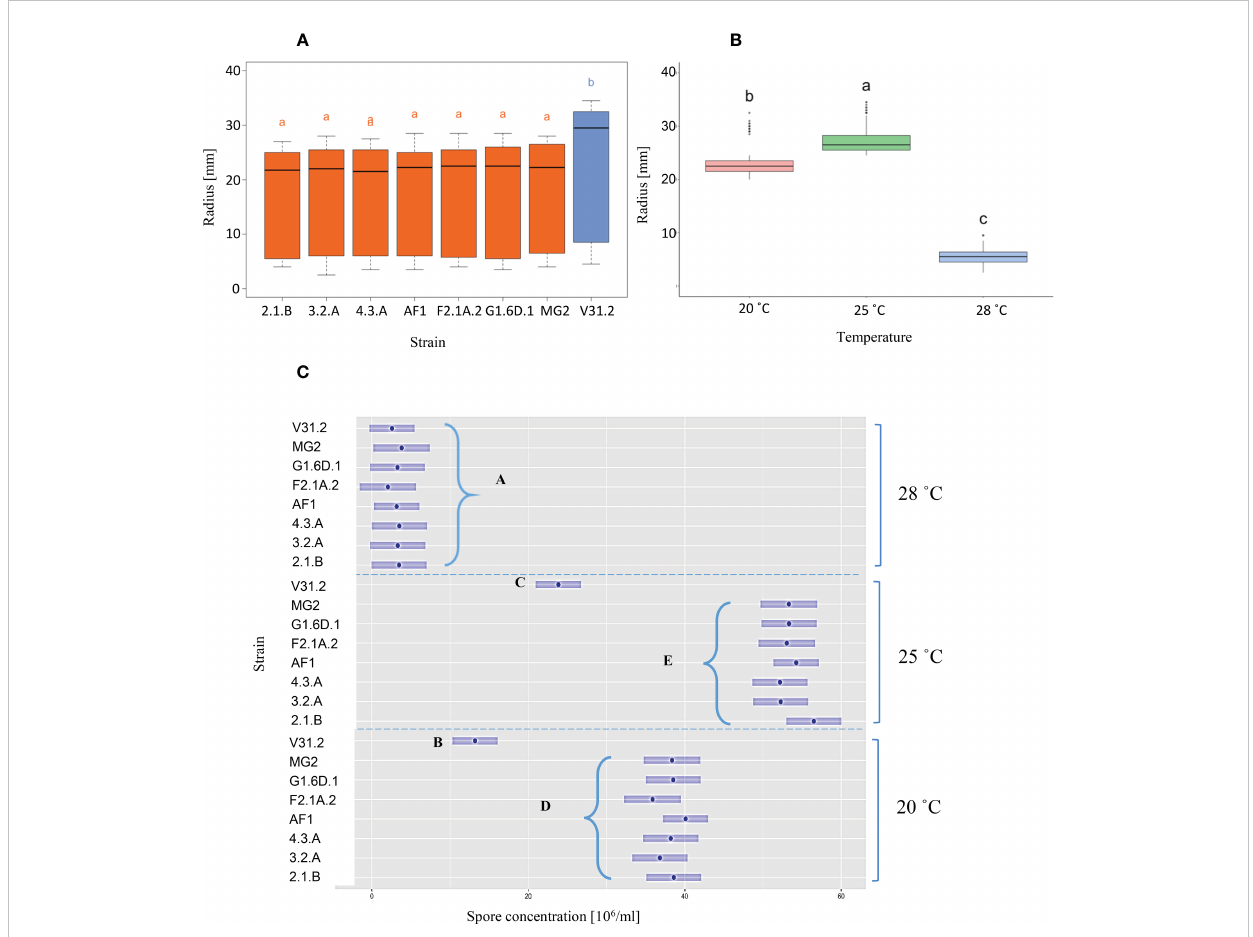
FIGURE 2 Radial gowth and sporulation of V. alfalfae strains at 20 °C, 25 °C and 28 °C. Fungal isolates were cultured on PDA in darkness and hyphal growth was measured as radius during 14 days at regular intervals. Spores were harvested after 14 days. (A) Boxplot of strains ’ effect on radius after 14 days of growth, (B) Boxplot of temperatures ’ effect on radius after 14 days of growth. (C) Spore production as function of strain and temperature. The letters represent distinct groups by LSmeans based on the Tukey ’ s test. The experiment was performed in 3 independent repetitions, each with 3 Petri dishes per condition and strain.